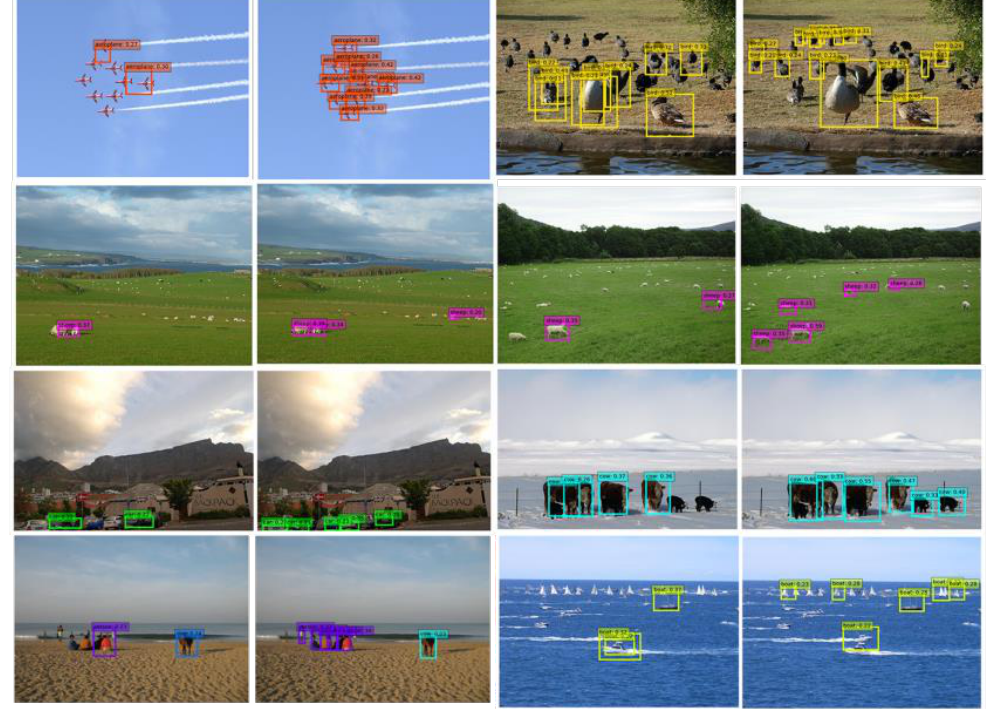
Figure 5. Comparisons of small object detection results between the classical You Only Look Once (YOLO) method (the first and third columns) and the Multi-view YOLO method (the second and fourth columns).